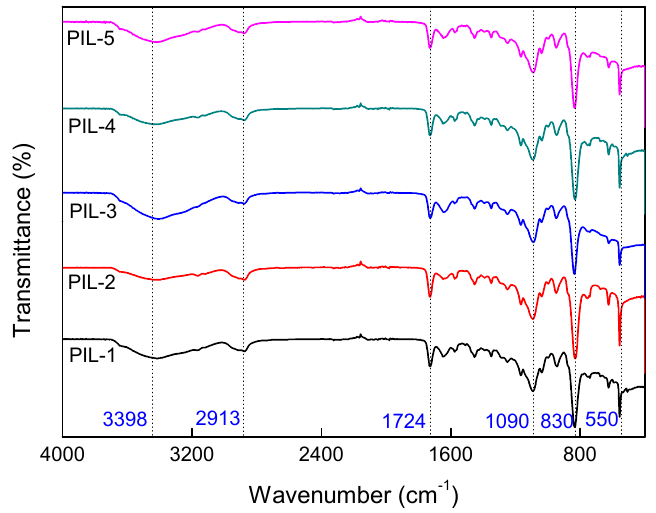
Figure 2. FTIR spectra of PILs synthesized under different temperature.